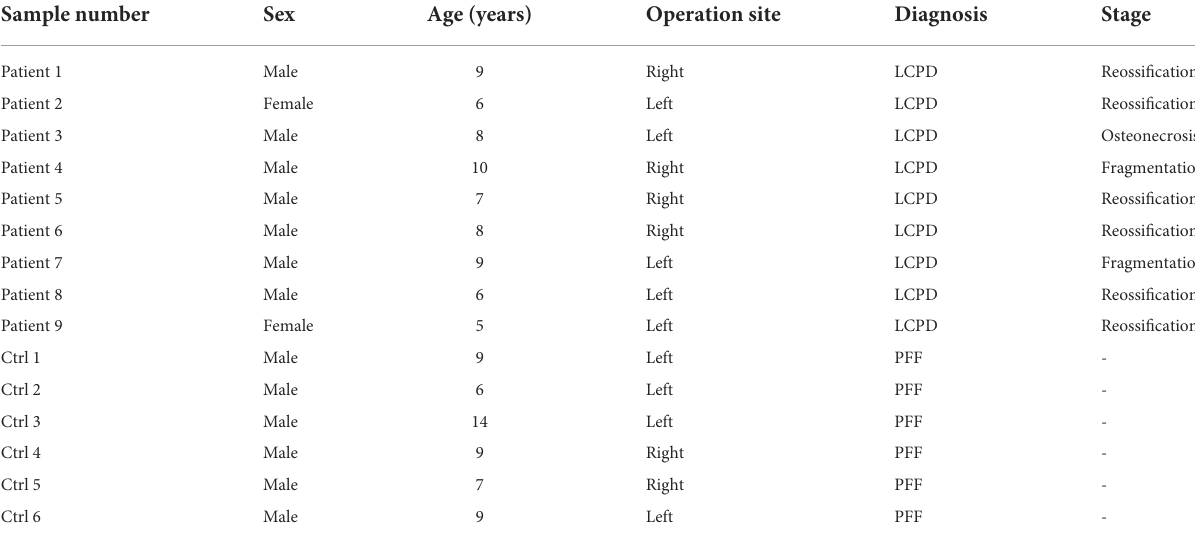
TABLE 1 The main clinical characteristics of the pediatric periosteum samples for Microarray. Sample number